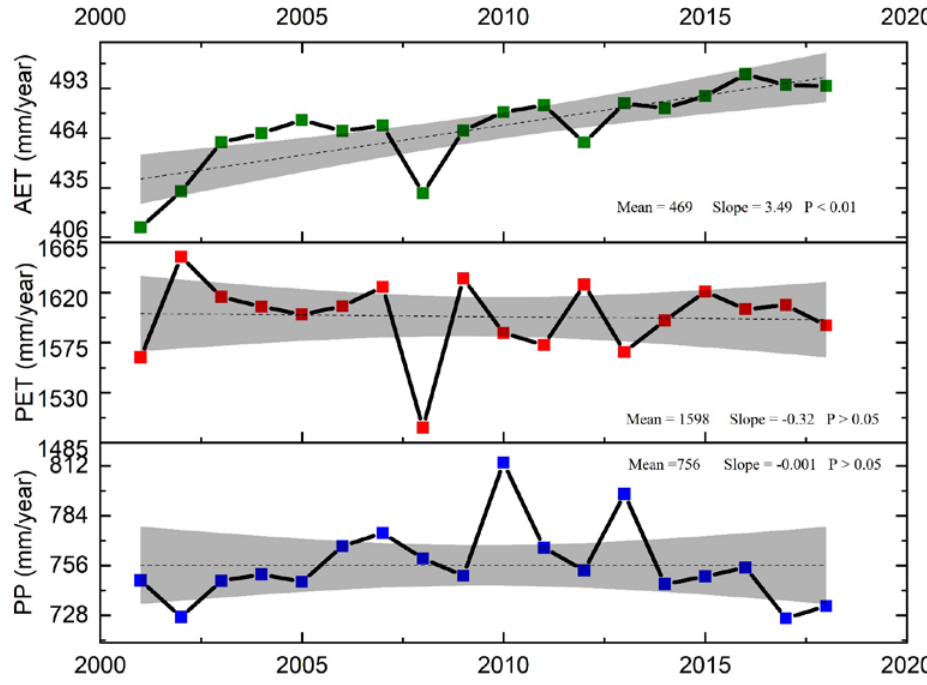
Figure 5. Time series of the croplands global annual mean for AET, PET, and PP.